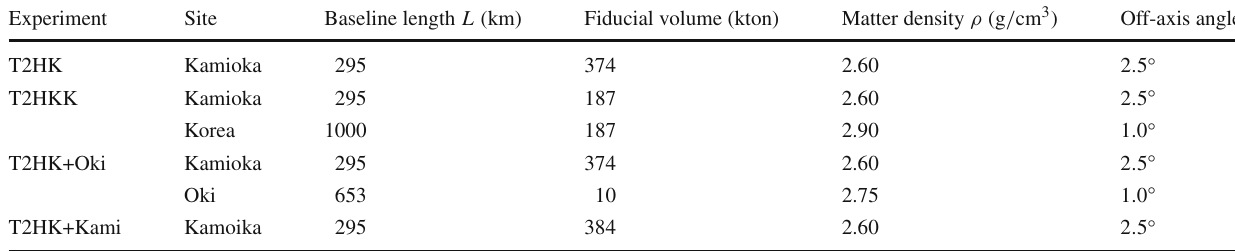
Table 2 Parameters assumed for the detectors used in the experiments